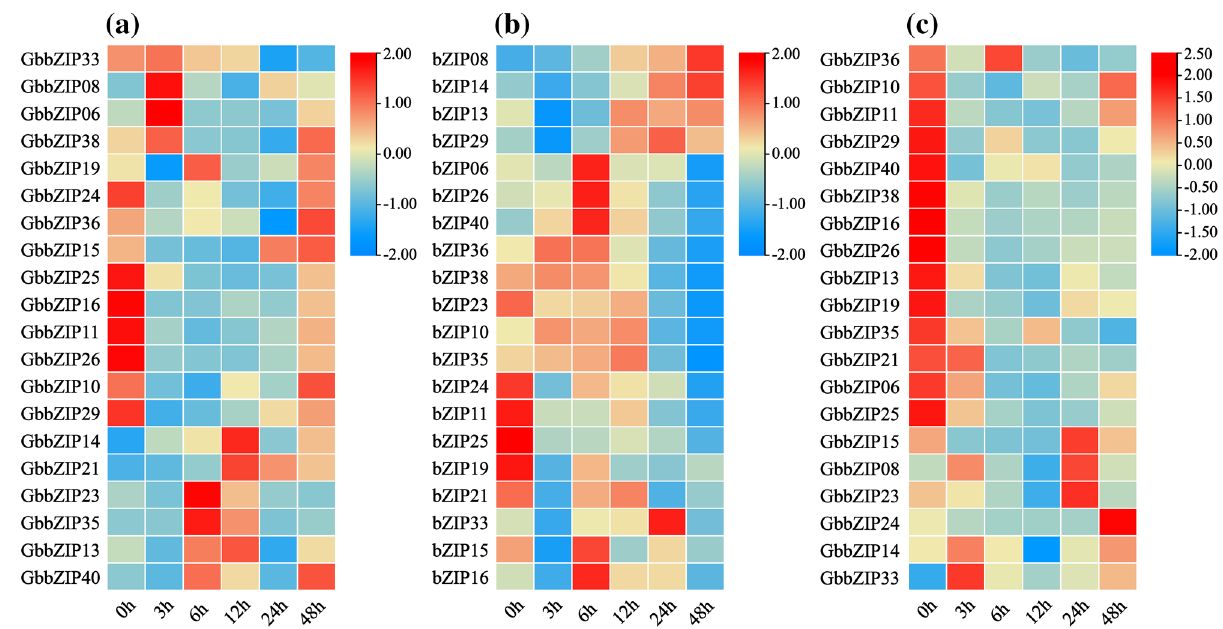
Figure 9. Heat maps of the relative expression of GbbZIPs under abiotic stress. ( a ) The relative expression of GbbZIPs under MeJA. ( b ) The relative expression of GbbZIPs under cold stress. ( c ) The relative expression of GbbZIPs under SA. Expression values are mapped to a color gradient from low (blue) to high (red)